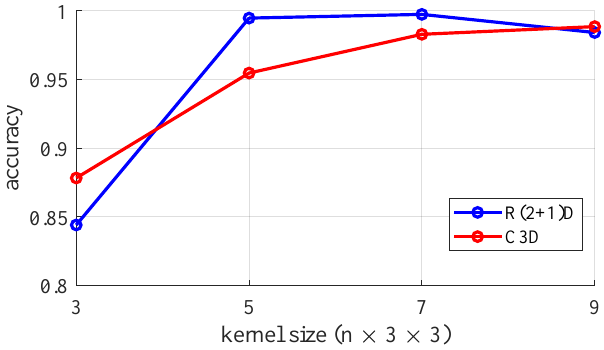
Figure 7. Classification accuracies of 4-class classification using different temporal depths for 3D convolution kernel.